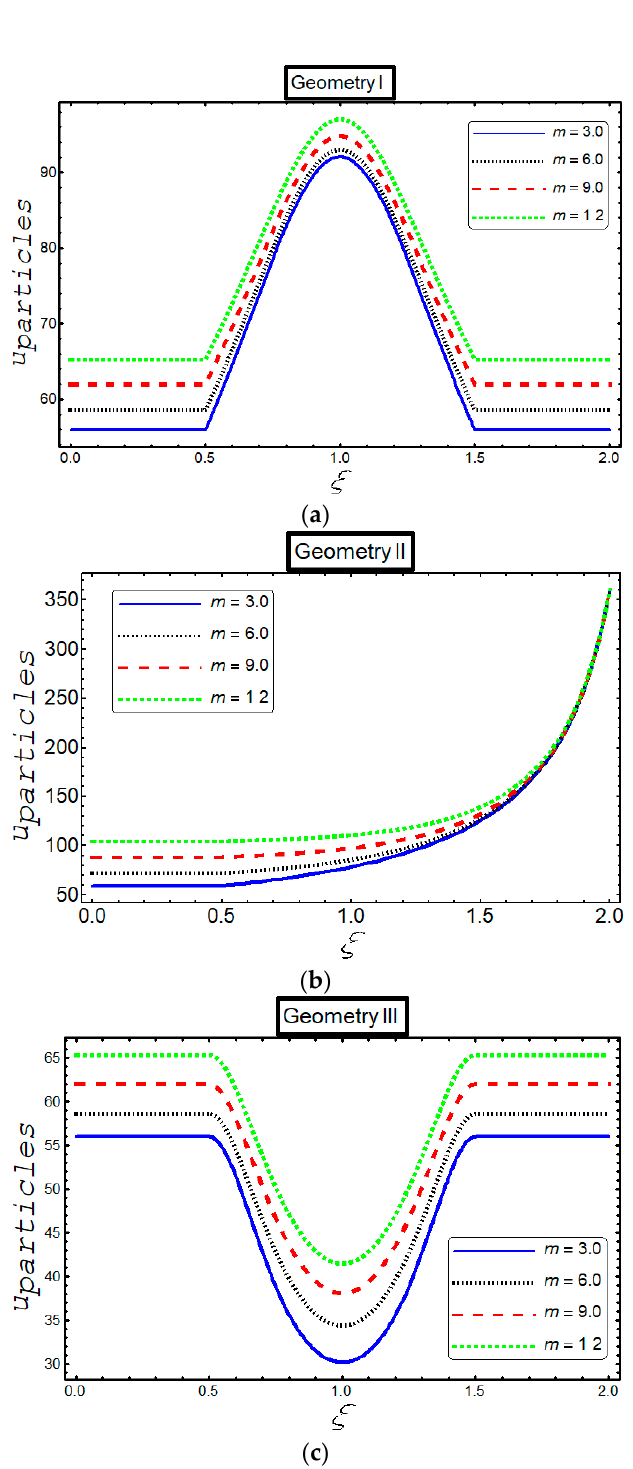
Figure 7. Velocity variation for electro-osmotic parameter.